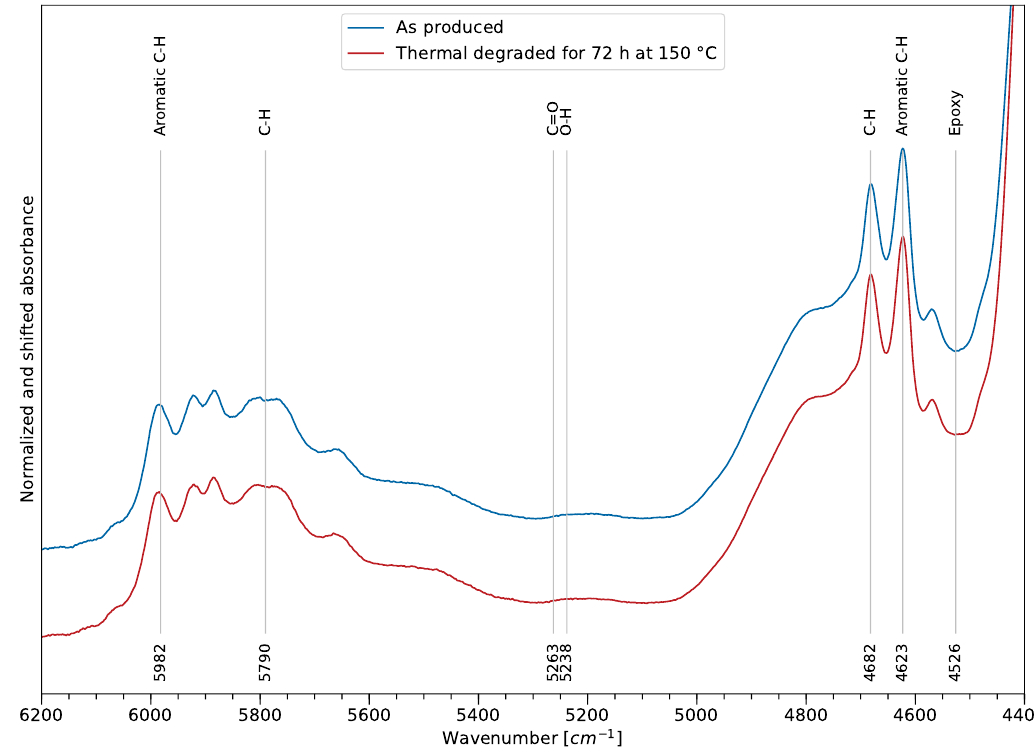
Figure 9. Overview of relevant FTIR bands in the NIR bandwidth, from 4400 to 6200 cm −